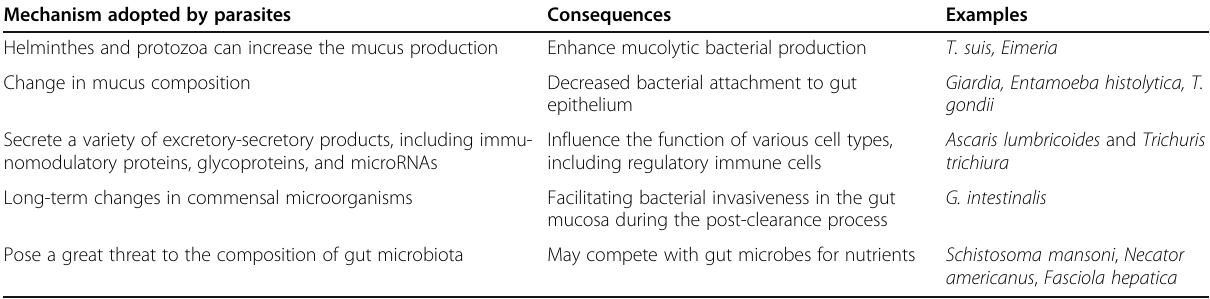
Table 1 Various mechanisms adopted by parasites and its consequences on gut ecology Mechanism adopted by